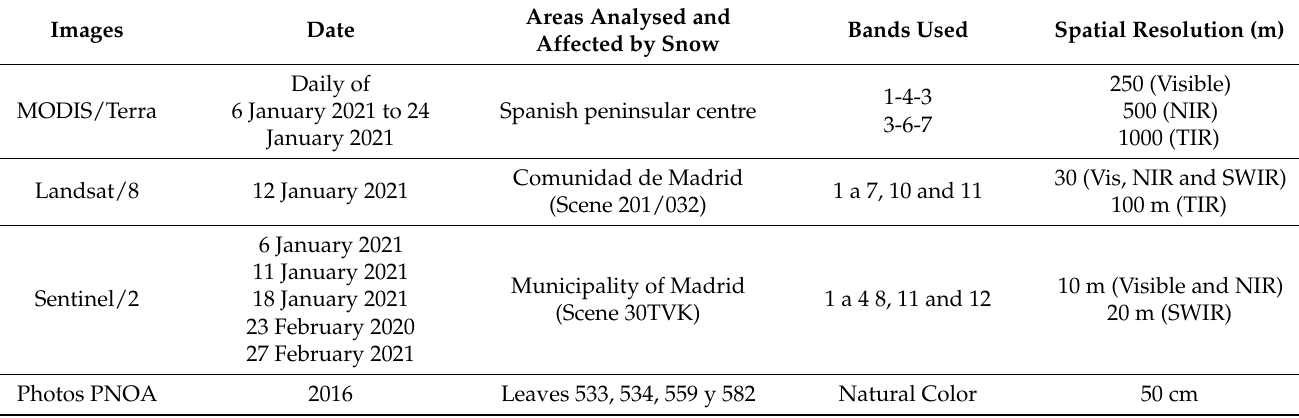
Table 2. Selection of satellite images